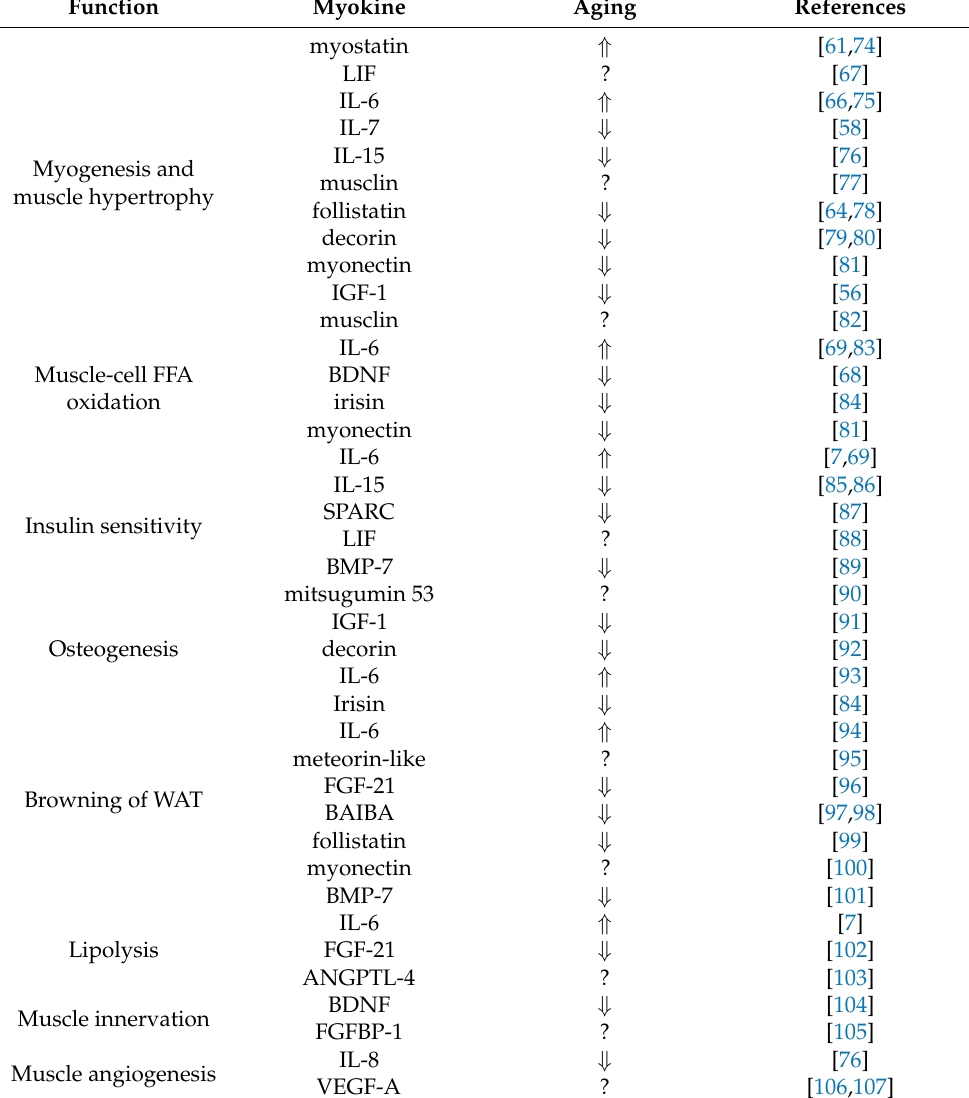
Table 1. Selected myokine